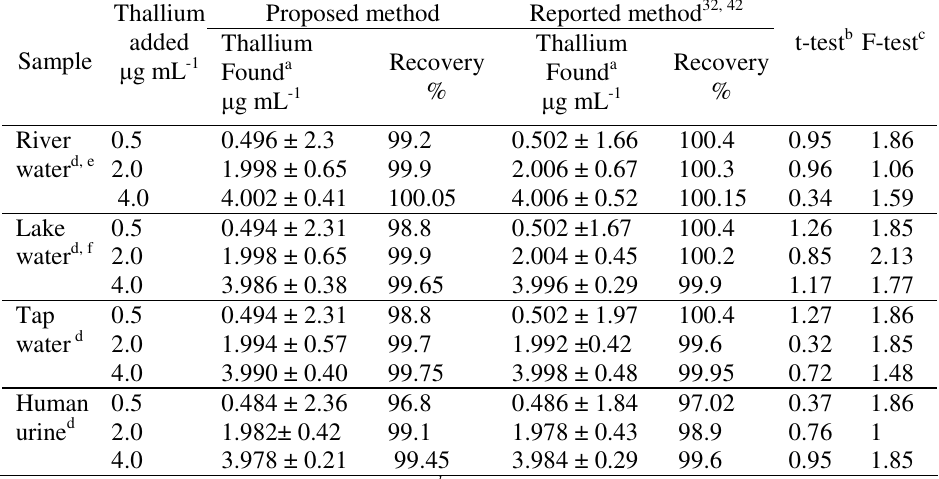
Table 4. Determination of Tl(III) in spiked different water and urine samples by a proposed method and reported methods.